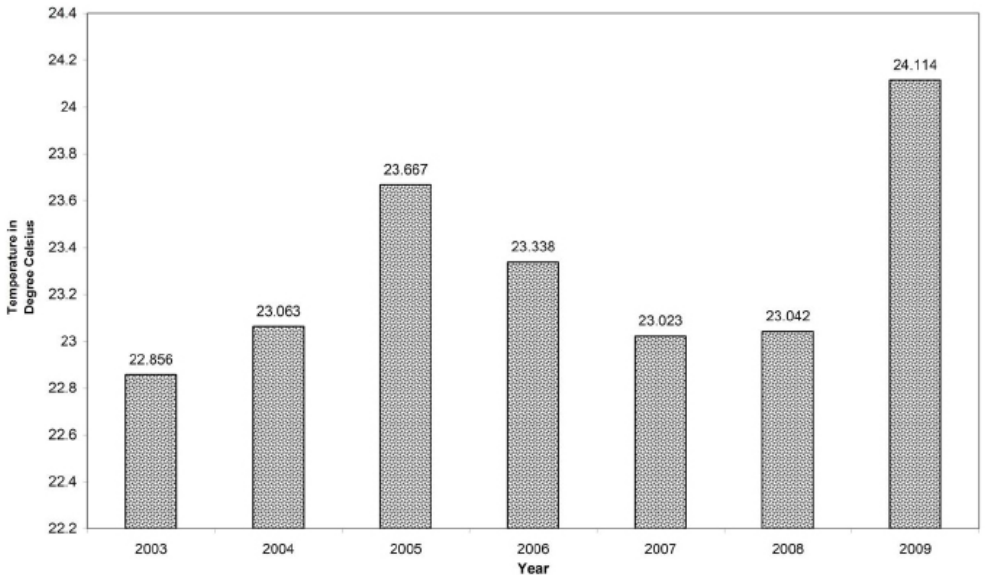
Figure 2. Change of SST in the month of January from 2003 to 2009 around the study area (1˚ × 1˚)